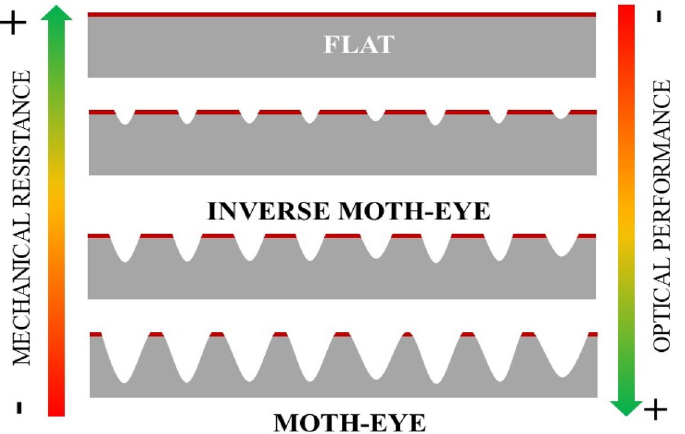
Figure 10. Schematic view of the nanostructure evolution during thermal R2R-NIL from flat PMMA to intruding nanocones and to fully developed moth-eye structure showing a reduced contacting surface (red lines in each case).